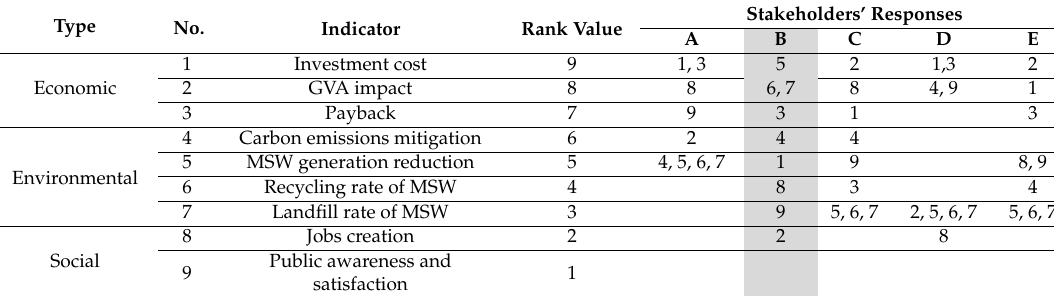
Table 3. The indicators key on the left and stakeholders’ responses on the